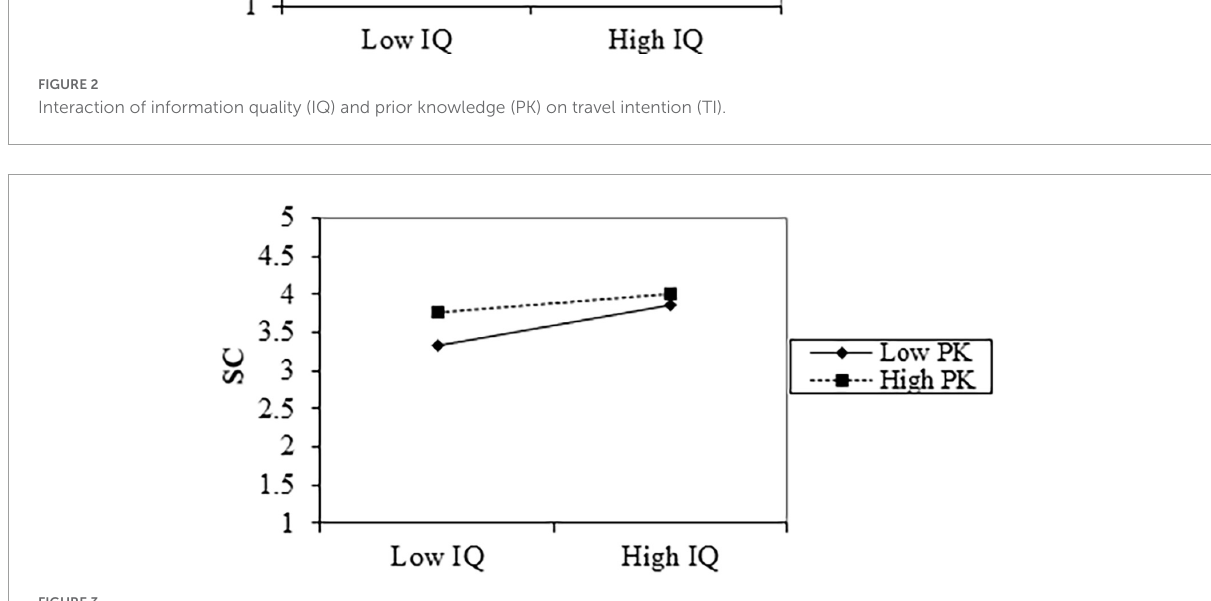
FIGURE3 Interaction of information quality (IQ) and prior knowledge (PK) on self-congruity (SC).